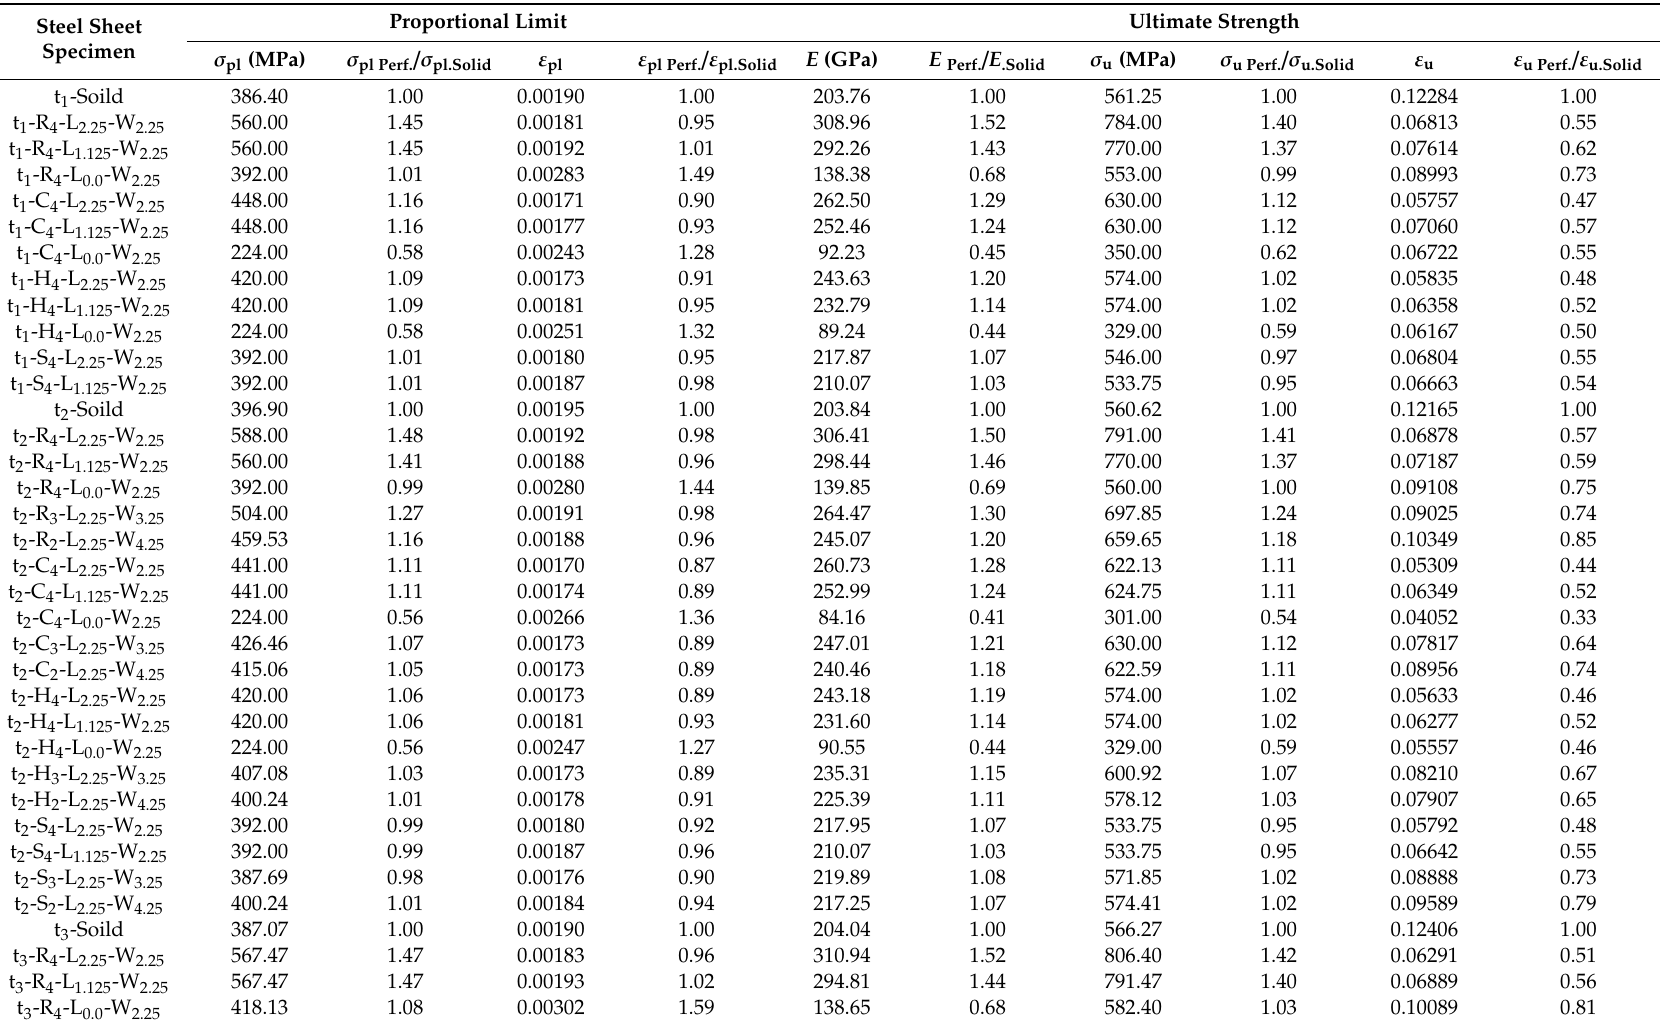
Table 3. Summary of steel sheet specimens with perforated based on FE results in the present